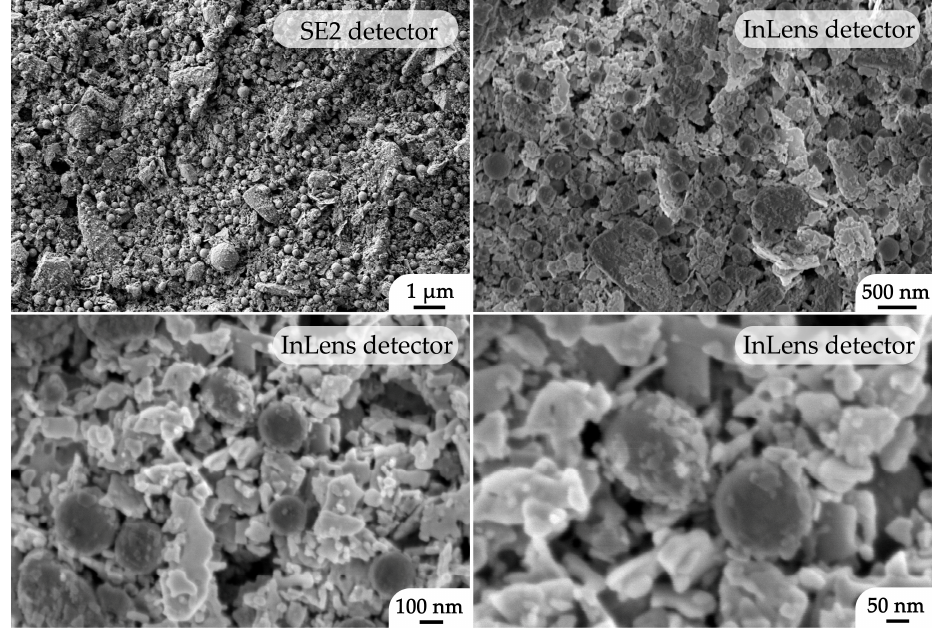
Figure 7. Microstructure of the NiO–SDC composite film printed on an Al 2 O 3 substrate surface (according to SEM data).